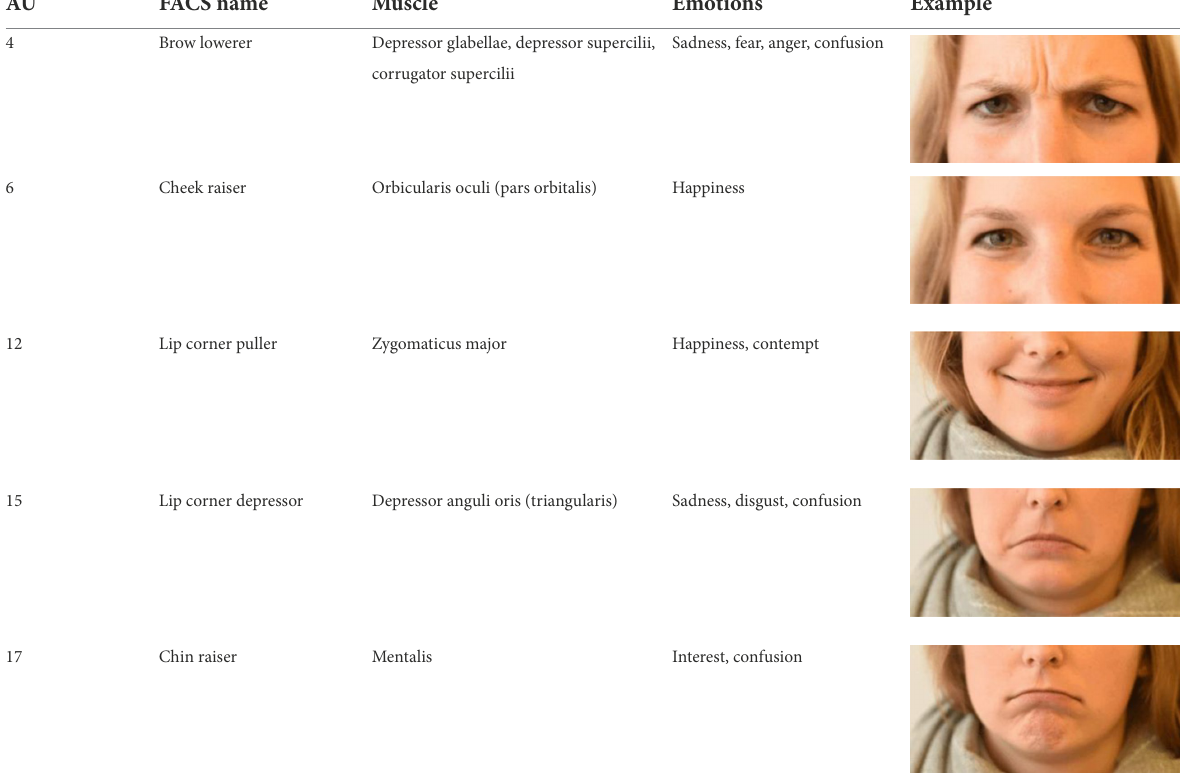
TABLE 1 The five Action Units (AUs) that were used for analysis.